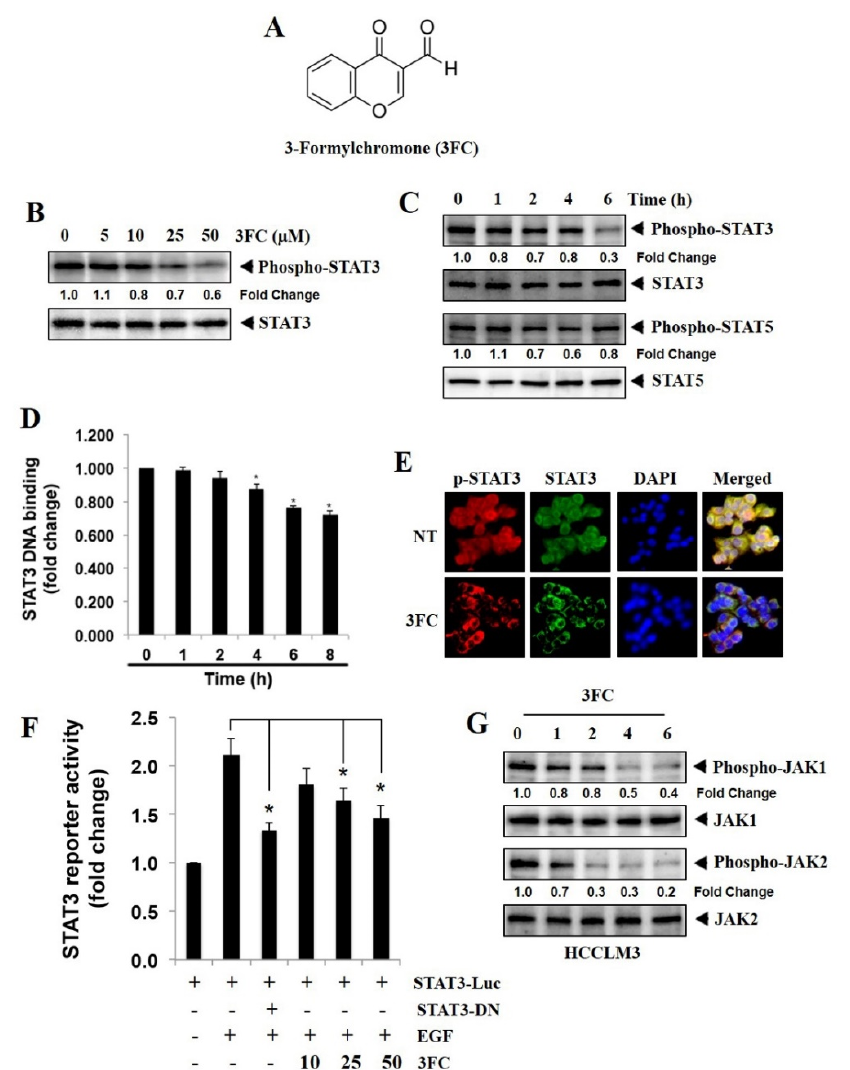
Figure 1. 3-formylchromone (3FC) inhibits the activation of the signal transducer and activator of transcription 3 (STAT3). ( A ) Chemical structure of 3FC. ( B ) Effects of 3FC on STAT3 phosphoryla-